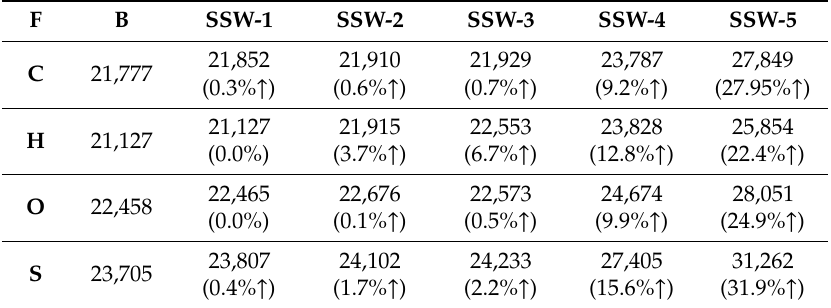
Table A7. Travel distance for residents in St. Lazarus Parish to